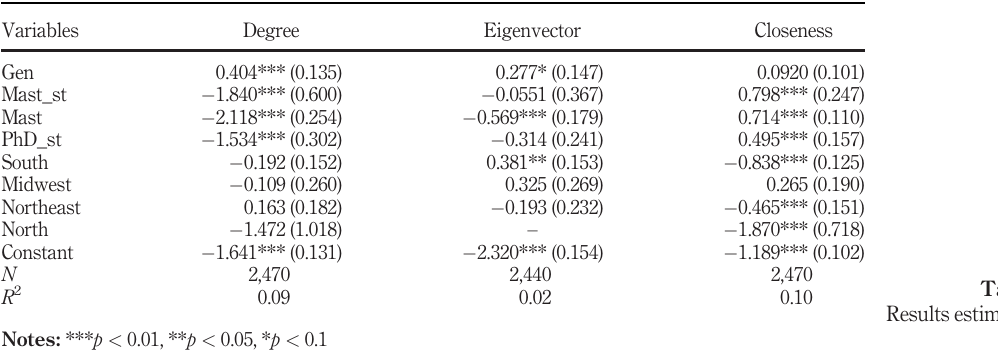
Table V. Results estimated